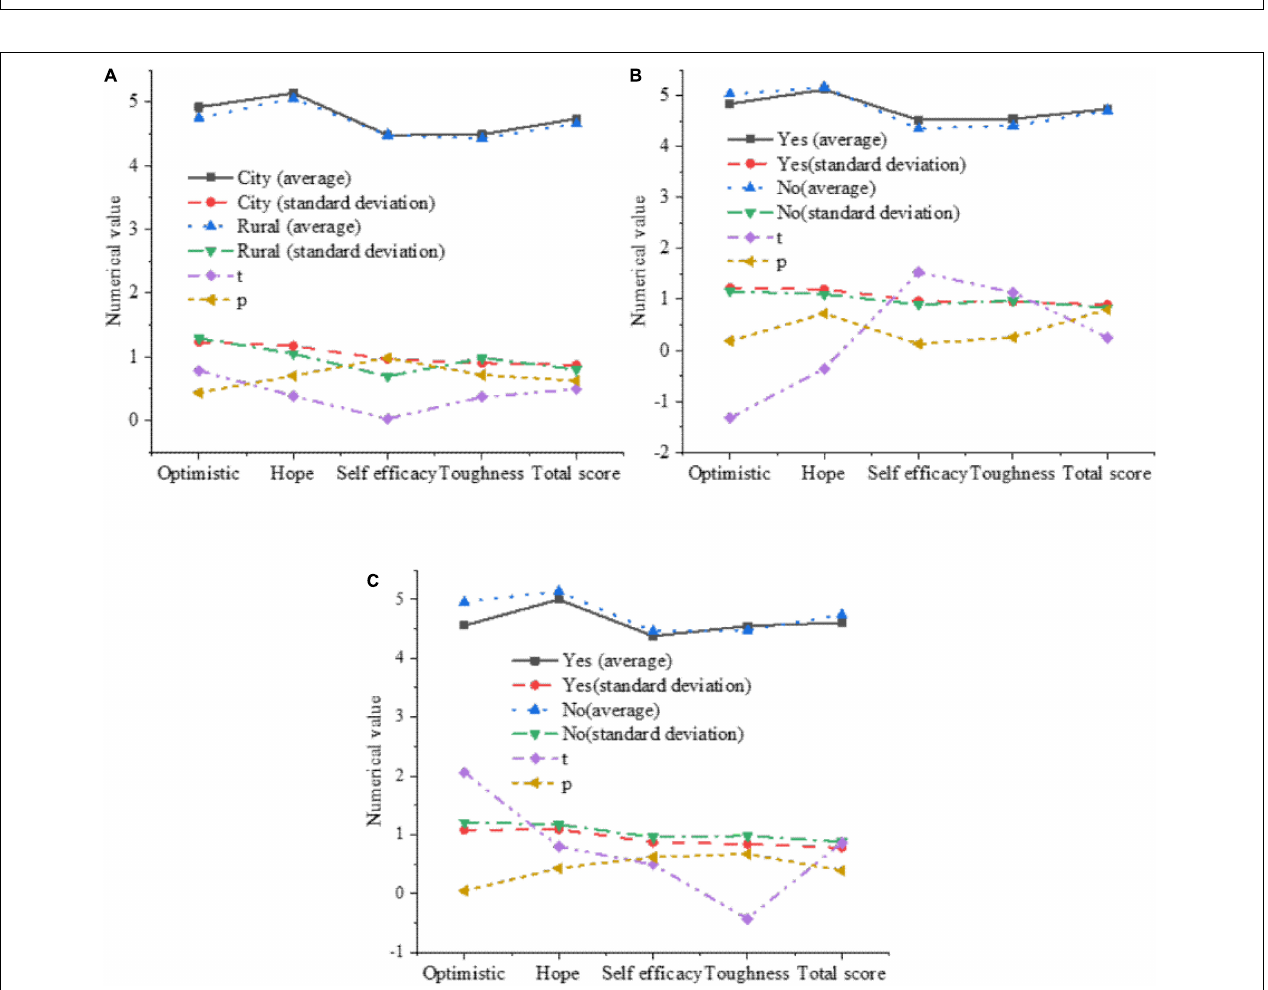
FIGURE 7 | The statistical results of the psychological quality of college students. (A) Overall situation of psychological quality. (B) Detection rate of psychological quality.